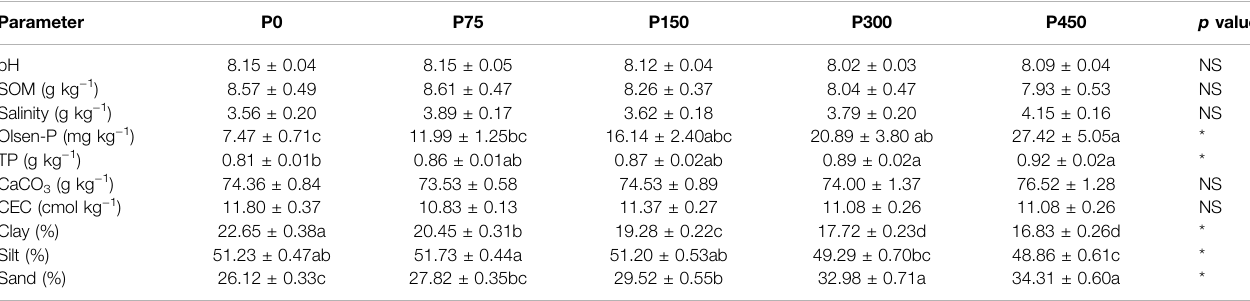
TABLE 2 | Mean values of soil properties (0 – 40 cm) of different treatments under 4-year fertilization.